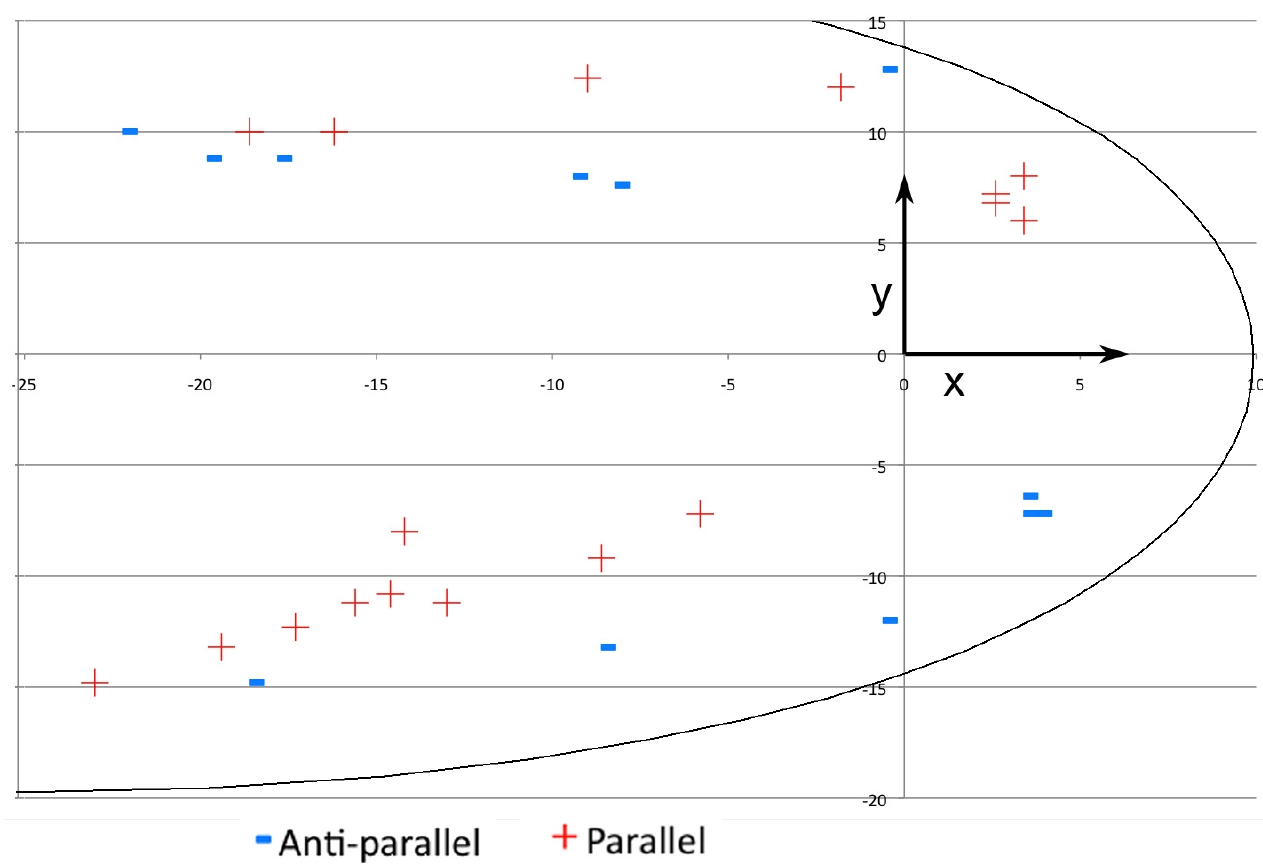
Fig. 11. X - Y plot of the vortex rotation directions referred from the right-hand rule following the local magnetic field dominant component. The ones on the dayside followed a pattern; the ones on the duskside rotated parallel to the field while the ones on the dawnside rotated antiparallel. The black curve represents the magnetopause location as calculated by the BATS-R-US model for the last time step in case 2.